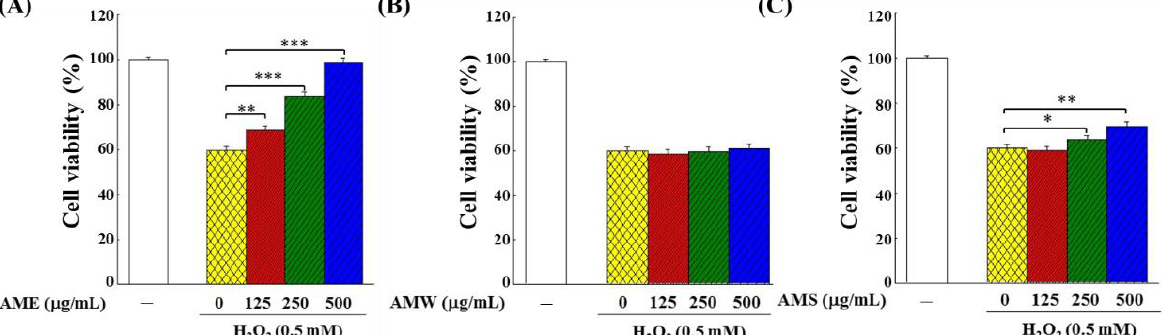
Figure 5. Protective effects of the three AMf extracts on the growth of PC12 cells under the H 2 O 2 stimulation in Prevention mode: ( A ) AME, ( B ) AMW and ( C ) AMS. The cells were first cultivated for 24 h, treated with specific extract at indicated concentration for another 24 h, then stimulated with 0.5 mM H 2 O 2 for 4 h. Cell viability was analyzed with an MTT kit. The control group was the PC12 cells grown without treatment with extract sample and H 2 O 2 stimulation. The cell number of this group was set as 100%. This experiment was repeated five times. The significance of the difference in data compared to the vehicle (group 0) are labeled as * p < 0.05, ** p < 0.01 and *** p < 0.001.